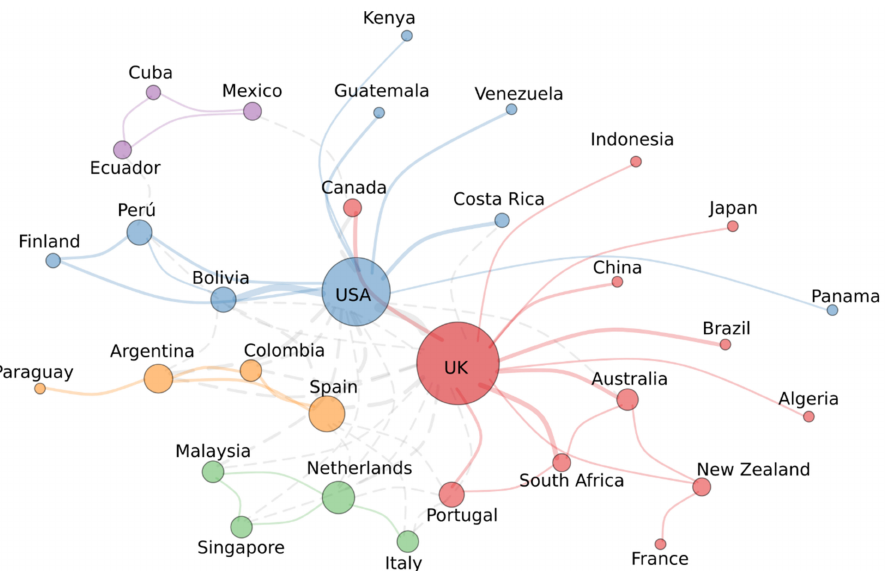
Figure 8. International collaboration network recorded in the illegal parrot trade literature. Circle size is proportional to the number of authors with a given country affiliation. Only the 40 most frequent country affiliations are shown. Collaboration nodes are represented by different